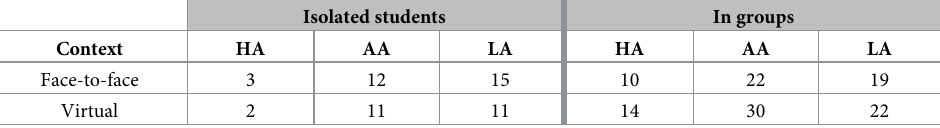
Table 5. Number of students who were grouped or claimed to be in a group and the isolated students for each context. Isolated